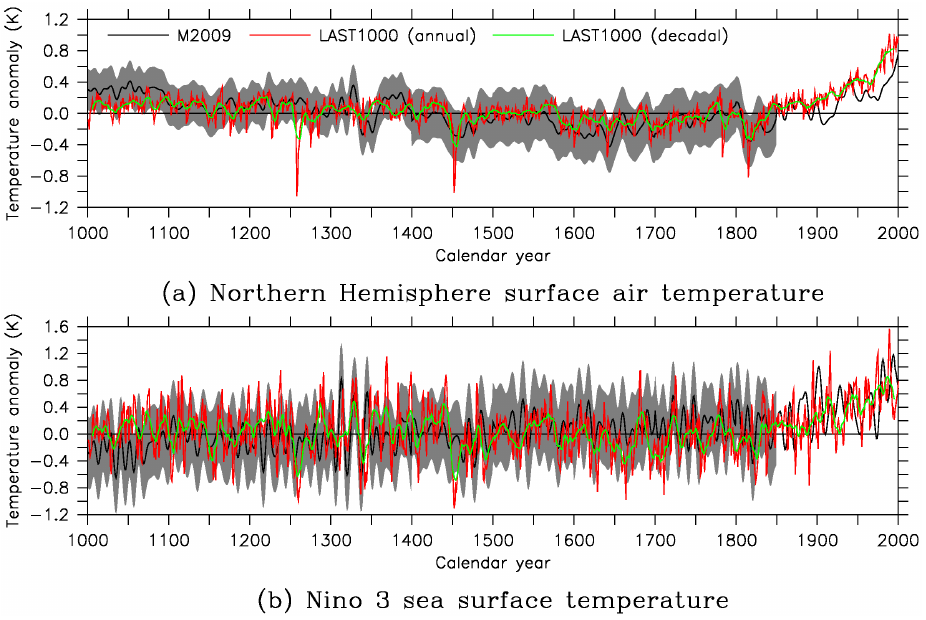
Fig. 14. The changes in surface temperature over the last millennium according to the “all proxy” timeseries of Mann et al. (2009) (black) and experiment LAST1000 (annual values in red, 10-yr running mean in green): (a) Northern Hemisphere surface air temperature, and (b) Ni˜no 3 sea surface temperature. The values shown are expressed as anomalies relative to the 1001–1850CE mean. The 95% confidence interval for Mann et al. (2009) is indicated by grey